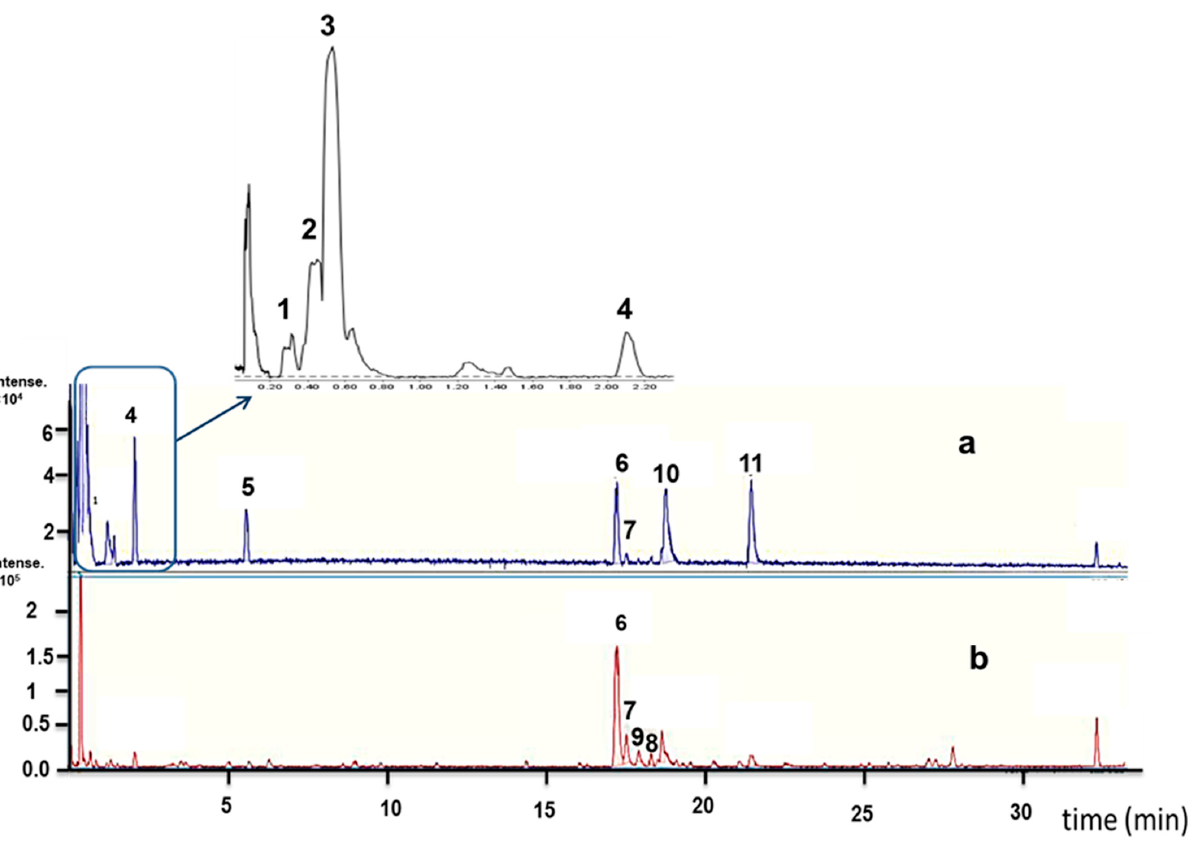
Figure 3. LC-MS base peak chromatogram (BPC) in: ( a ) positive ion mode. ( b ) Negative ion mode of the seedling alfalfa exudate. The peak numbers correspond to the identified compounds listed in Table 1.